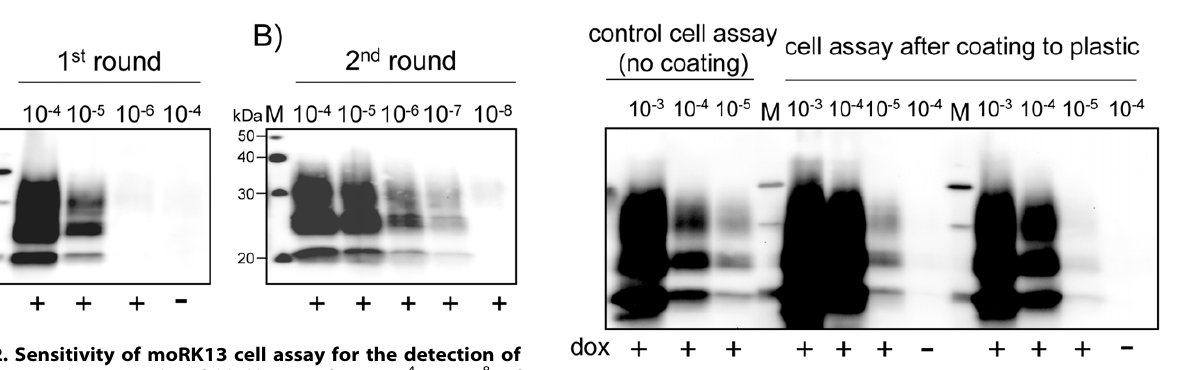
Figure 2. Sensitivity of moRK13 cell assay for the detection of RML mouse prions. Serial 10-fold dilutions (from 10 2 4 to 10 2 8 ) of RML 10% brain homogenate were inoculated in duplicate to moRK13 cells and the inoculated cultures were proceeded as in figure 1D. PrP res was analyzed by western blot after one (A) or two rounds (B) of cell assay. M are standard molecular mass marker proteins in kDa.